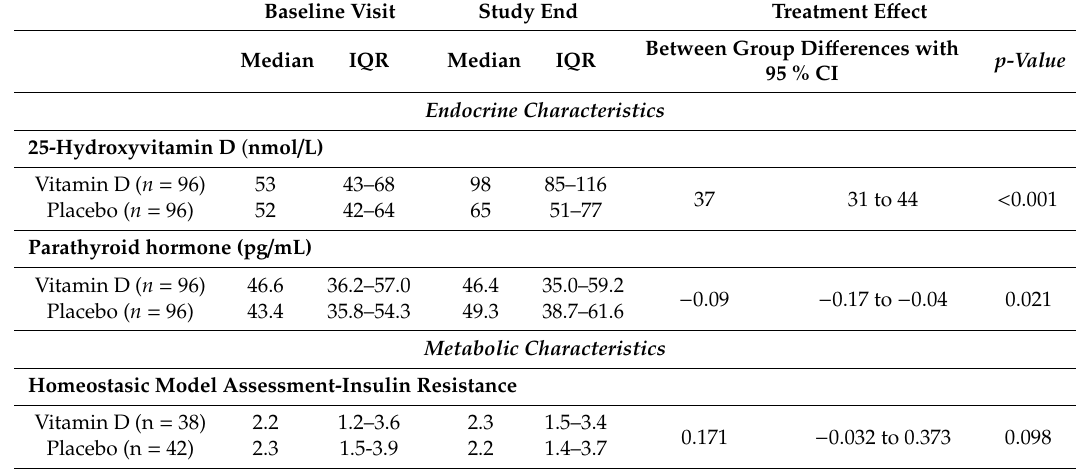
Table 2. Continuous outcome variables at baseline and follow-up at study end (12 weeks) in study participants with available values at both study visits. Data are shown as medians and interquartile range. Treatment e ff ects with 95% confidence interval and p -values were calculated by ANCOVA for group di ff erences at follow-up with adjustment for baseline